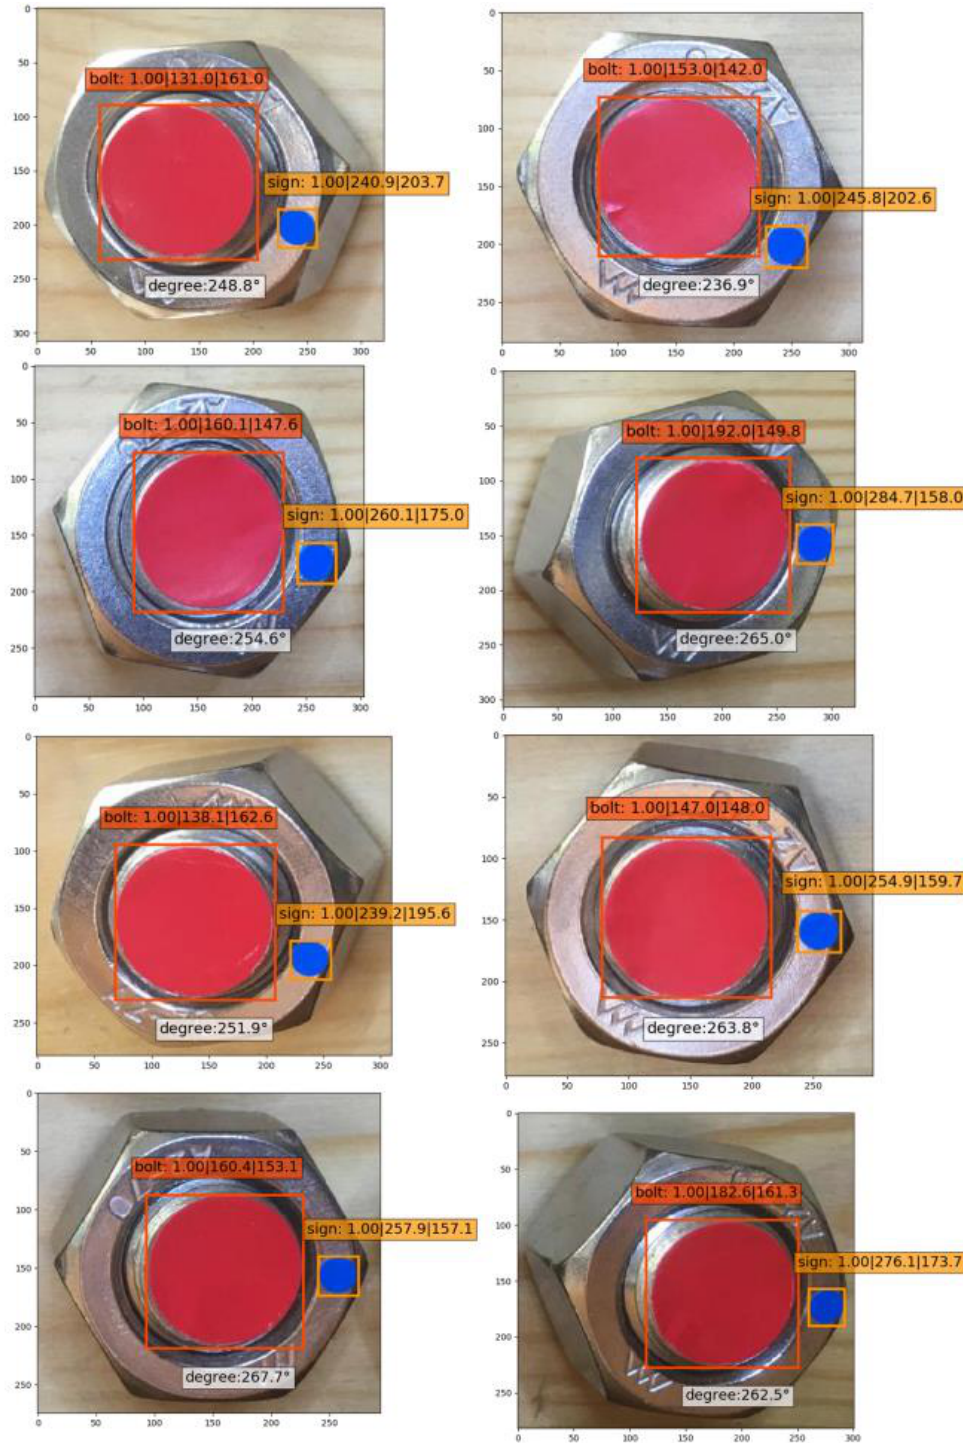
Figure 19. Identification results of an eight-bolted connection after